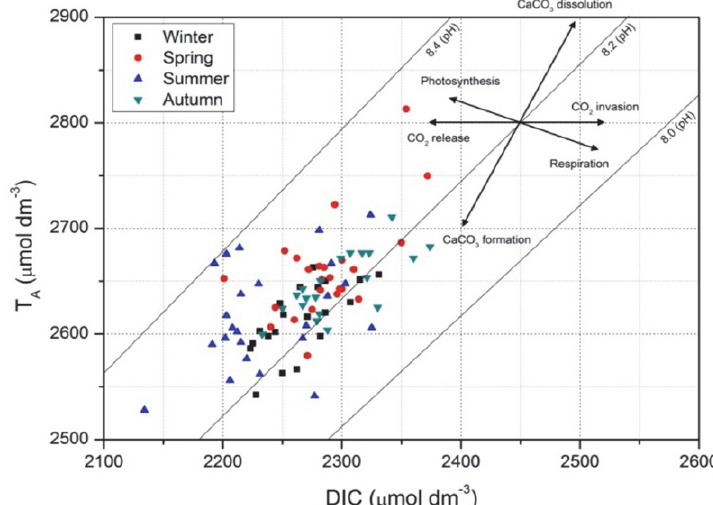
Slika 6. Nomogram med alkalnostjo (T A ) in raztopljenim anorganskim ogljikom (DIC) 32 v Tržaškem zalivu (Oceanografska boja »VIDA«): zima (črno), pomlad (rdeče), poletje (modro) in jesen (zeleno). 17 Premice ponazarjajo konstantni pH kot funkcijo DIC in TA, puščice ponazarjajo vpliv procesov na porazdelitev TA in DIC: fotosinteza, respiracija, raztapljanje karbonata (CaCO 3 ), obarjanje karbonata (CaCO 3 ), raztapljanje atmosfers- kega CO 2 , sproščanje CO 2 v atmosfero